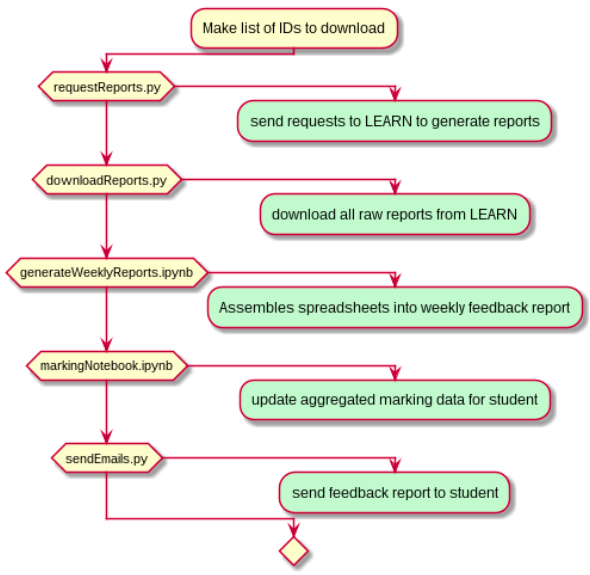
Figure A1. Flow chart of Python script sequences.